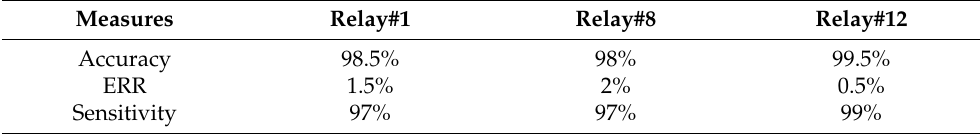
Table 12. Results of evaluation